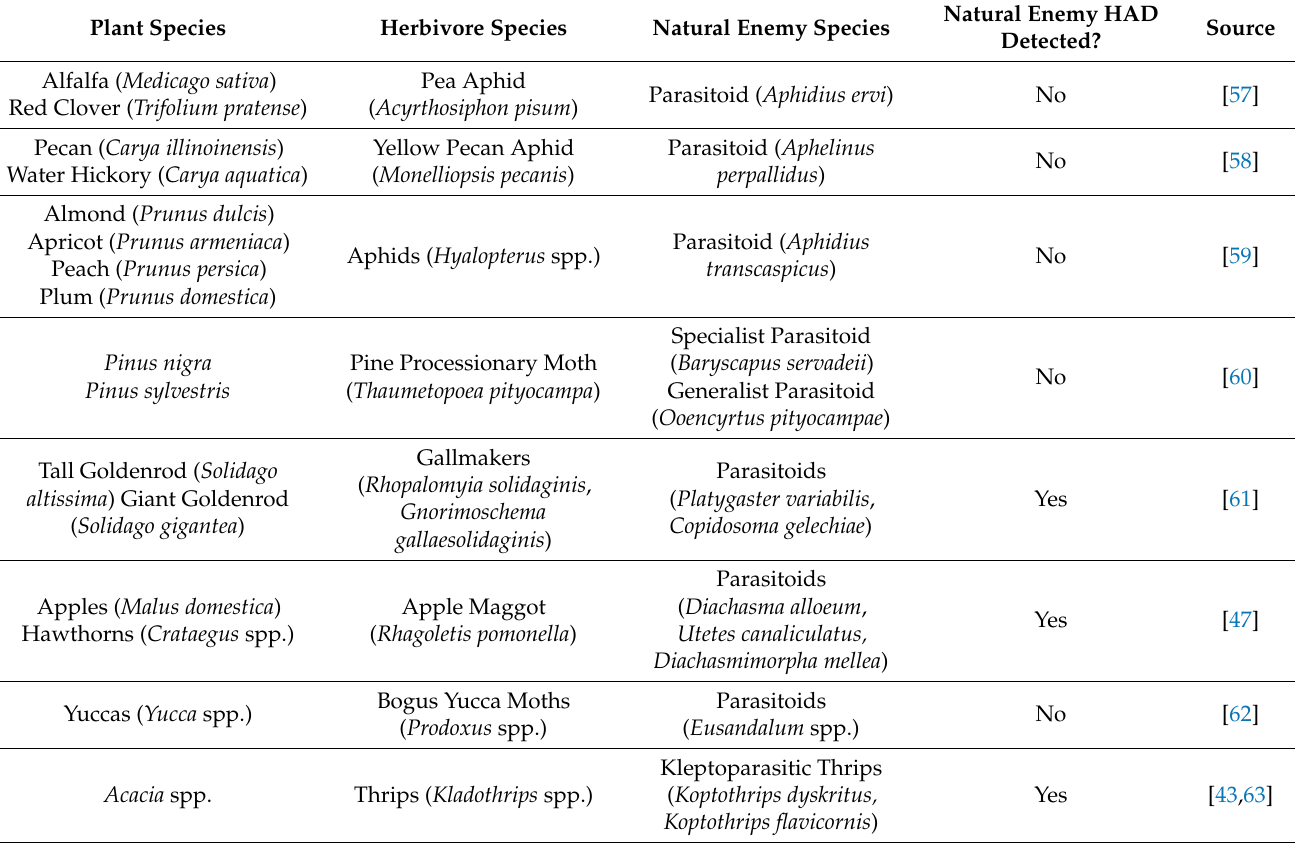
Table 1. Studies testing for sequential radiation in natural enemies, or natural enemy HAD in a single herbivore species which differentially associates with two host-plant species. To be in- cluded in this table, quantification of genetic difference between natural enemy populations was required. The genetic signature of HAD typically corresponds to F ST ≥ 0.15 between sympatric, host-associated